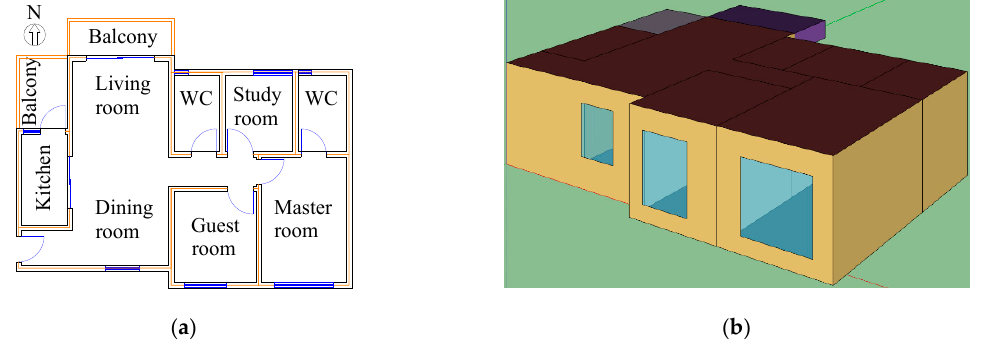
Figure 3. The building model for the orthogonal simulation: ( a ) plan of a top-floor dwelling; ( b ) the EnergyPlus model. Table 6. Building materials and their thermophysical parameters.